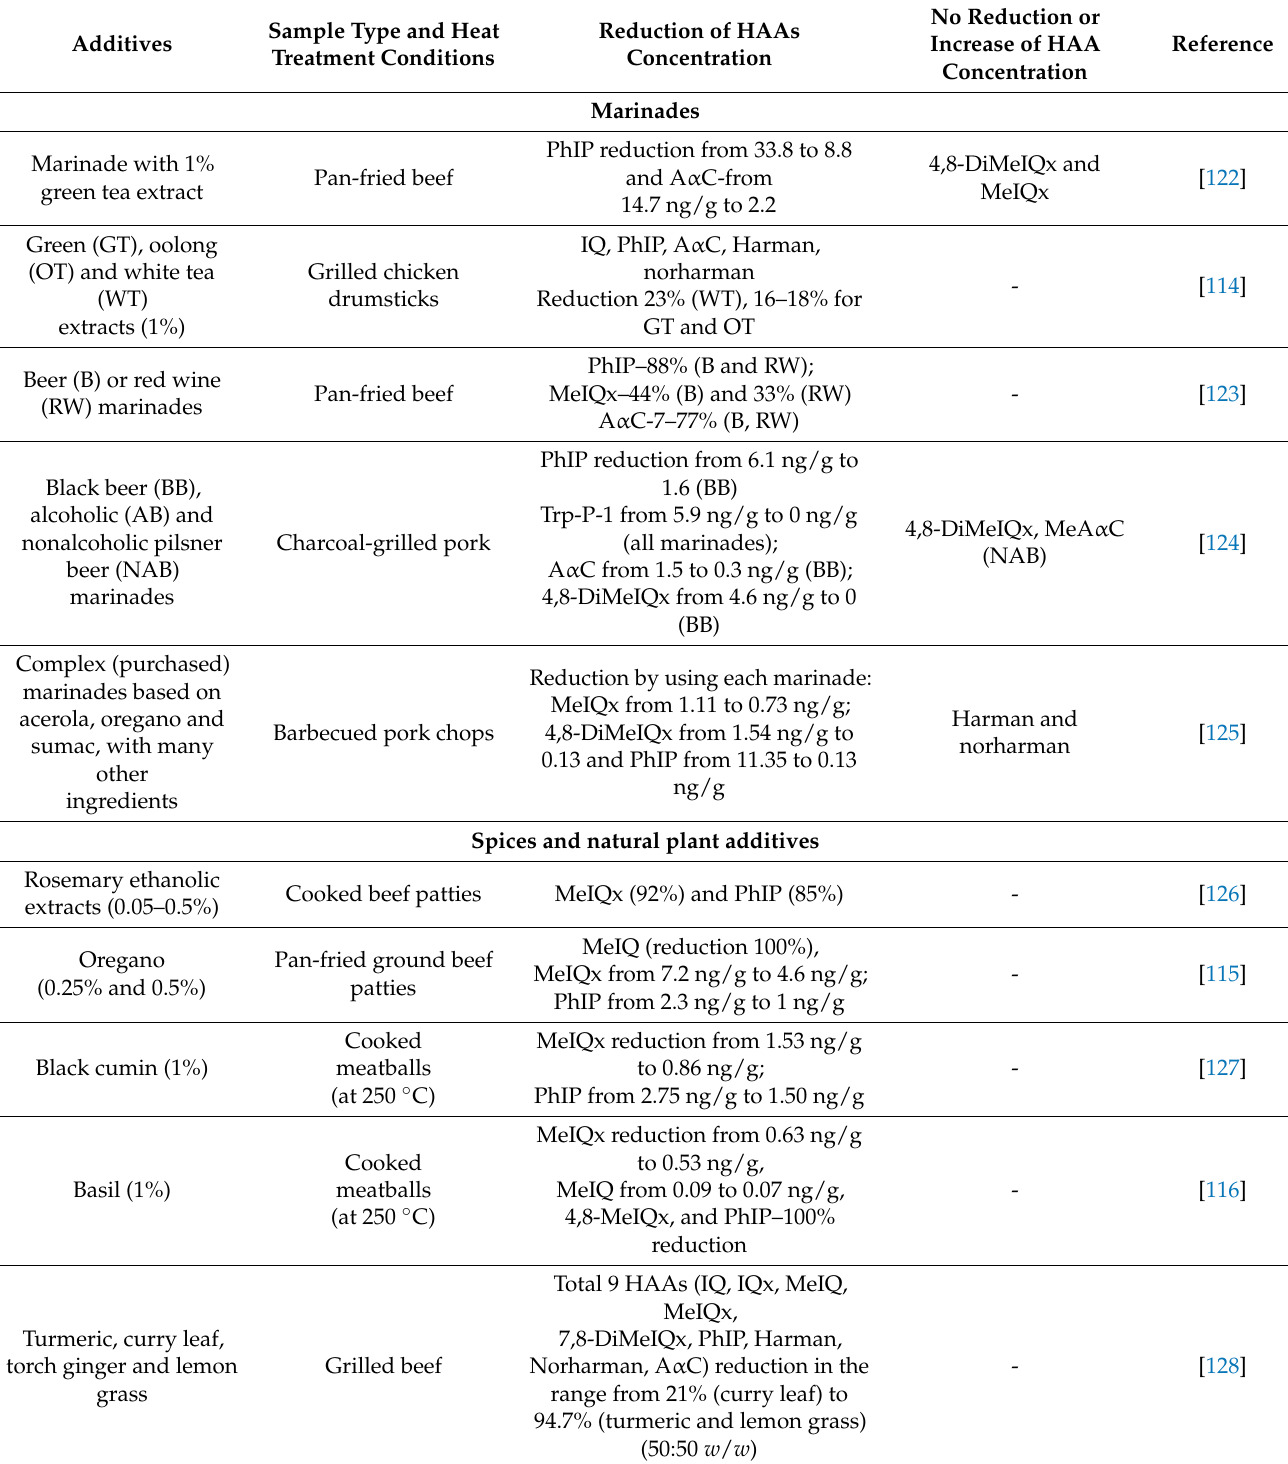
Table 4. Influence of marinating and spices or natural plant additives on HAA concentrations in cooked meat. Concentration changes are presented as given in the publications, i.e., in % or